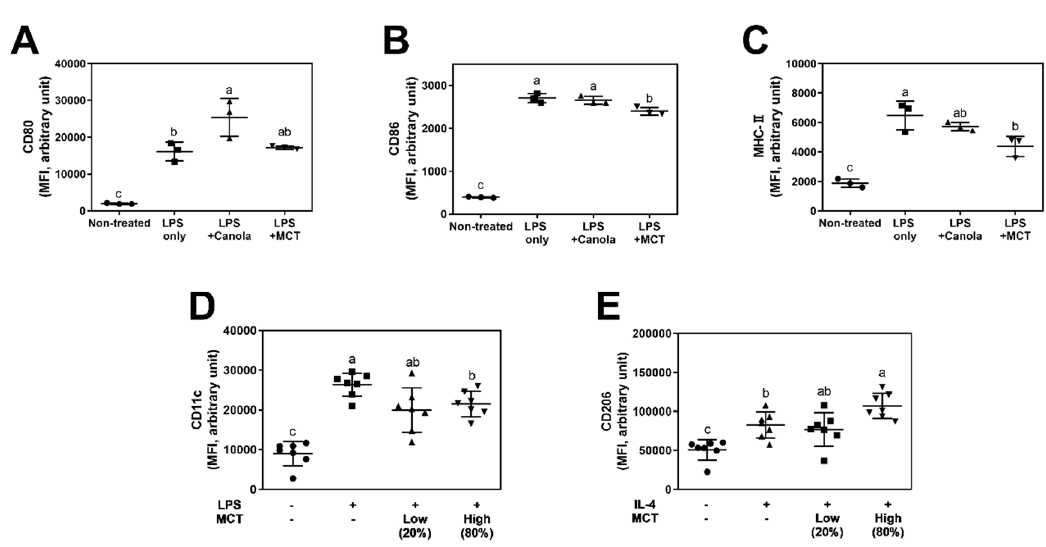
Figure 3. MCT induces macrophages to have anti-inflammatory phenotypes by modulating the expression of surface markers. CD80 ( A ), CD86 ( B ), and MHC-II ( C ) expressions of RAW 264.7 cells were evaluated following oil treatment and / or LPS stimulations ( n = 3). CD11c ( D ) was evaluated for the M1 marker and CD206 ( E ) for the M2 marker in BMDMs from mice fed with custom diets following LPS and IL-4 stimulation, respectively ( n = 7). Cells were stained with antibodies specific to surface molecules and analyzed by a flow cytometer. Values are indicated as mean ± SEM, and statistical significance is indicated with di ff erent letters ( p <